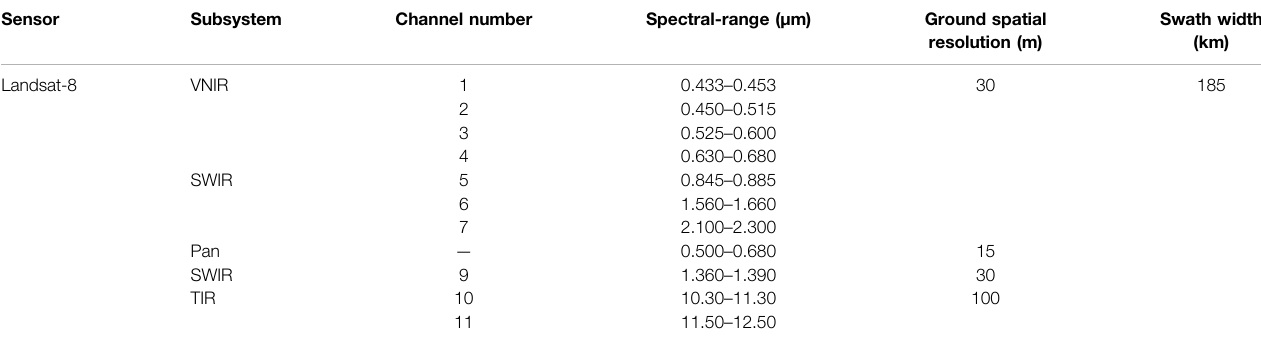
TABLE 1 | Spectral characteristics of remote sensing data used in this study.